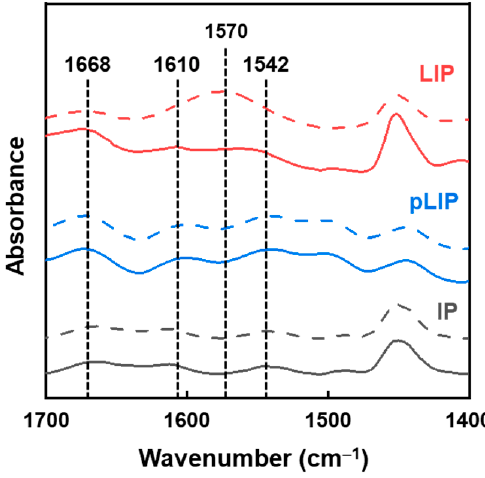
Figure 10. FT-IR spectra of the LIP, pLIP, and conventional IP membranes before (solid line) and after (dashed line) exposure to the acidic (2 h)/basic (2 h) condition.